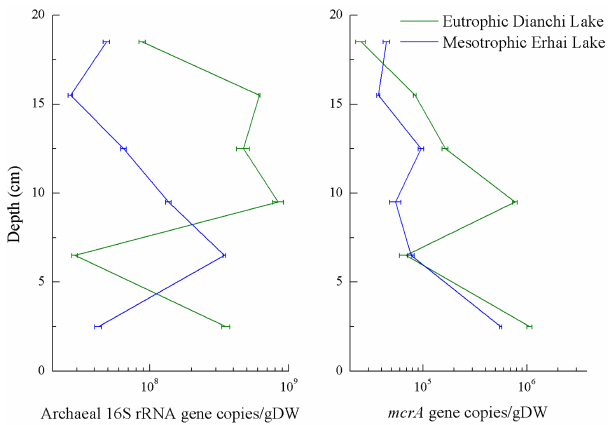
Figure 2. Abundance of archaeal 16S rRNA and mcrA genes at different depths. Error bars represent standard deviation of mean ( n =